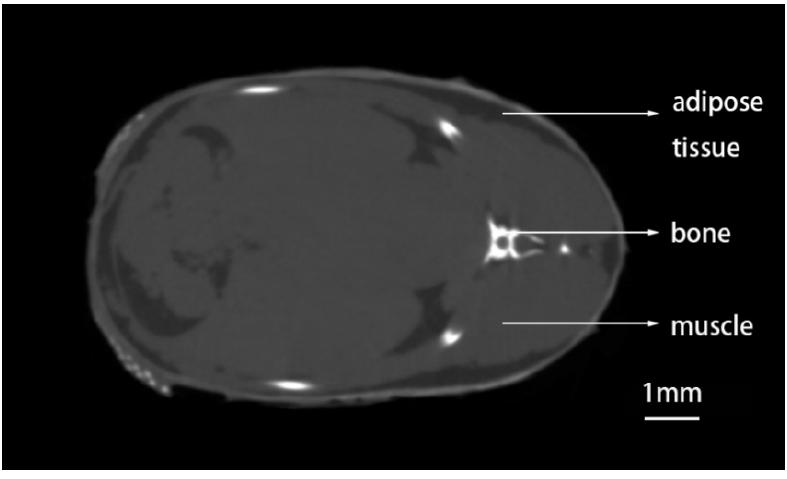
Figure 1. Micro-CT image of a zebrafish abdomen.